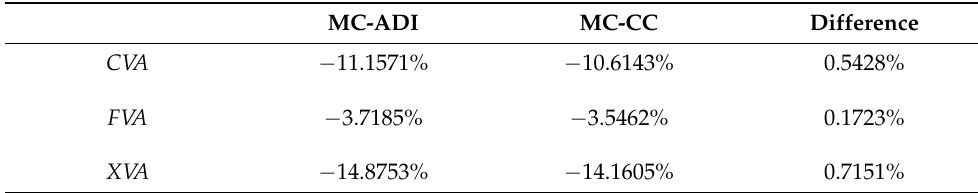
Table 4. CVA , FVA , and XVA of Rainbow Option , comparison and difference of the MC-ADI and MC-CC methods.